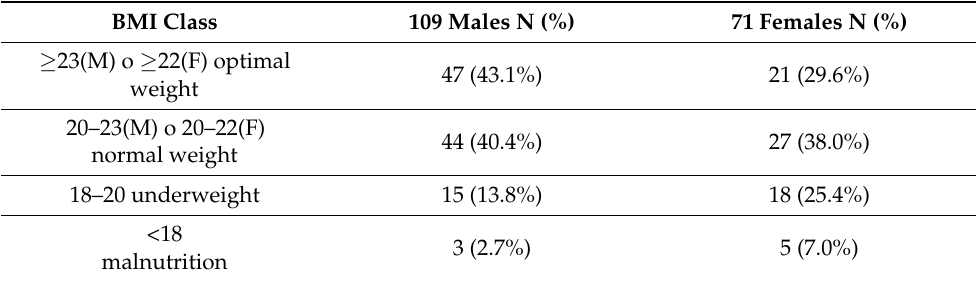
Table 3. Absolute values of BMI in